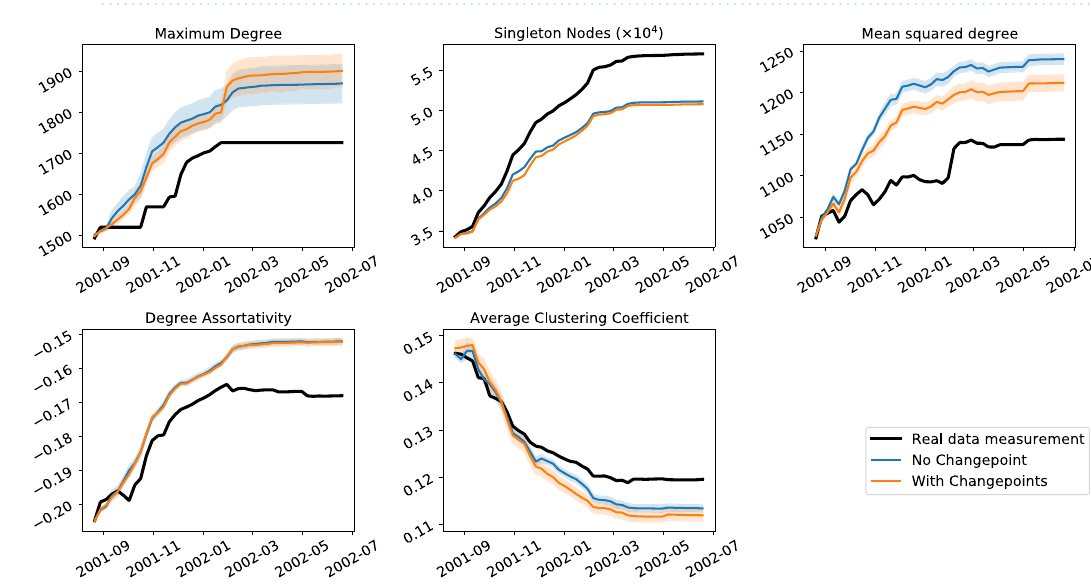
Figure 9. Best fitting (maximum likelihood) mixture of the BA, Triangle Closure and Random model over 10 time intervals. The Enron data is annotated with some key events in the company’s collapse.